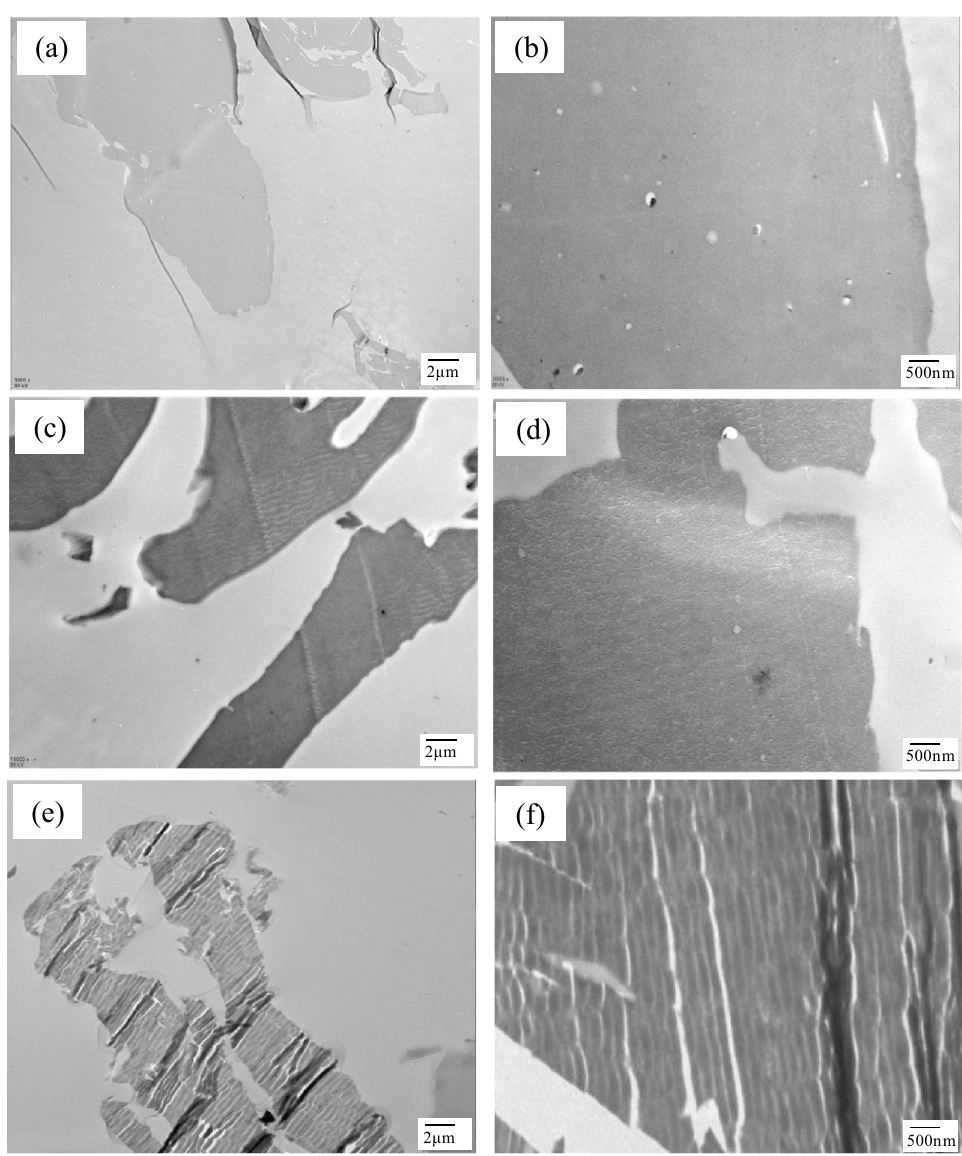
Fig. 3 Cross-sectional TEM images of W300 ( a , b ), W350 ( c , d ), and W550 ( e , f